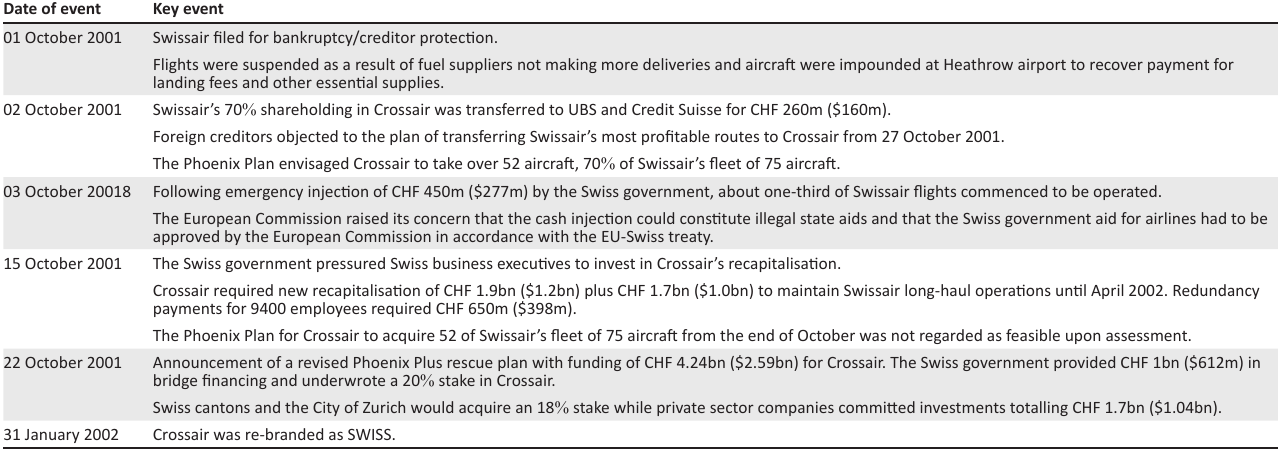
TABLE 5: Overview of key events in the transition from Swissair to